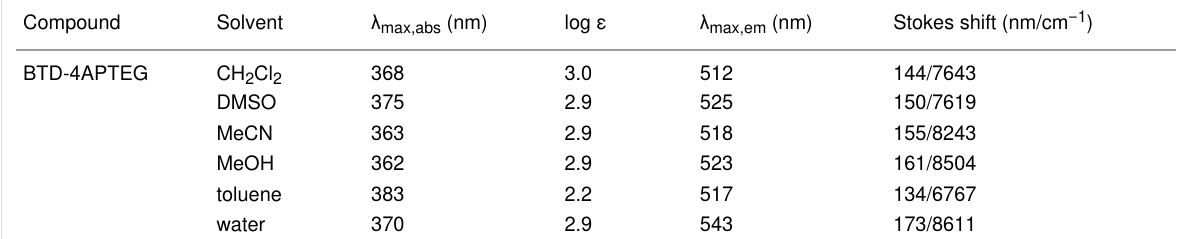
Table 1: UV–vis and fluorescence emission data (in different solvents at 10 μ M for all analyses) for the synthesized compound.